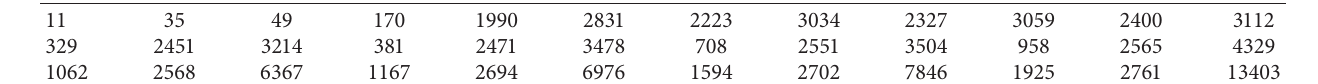
Table 2: Failure times for 36 appliances subjected to an automatic life test.